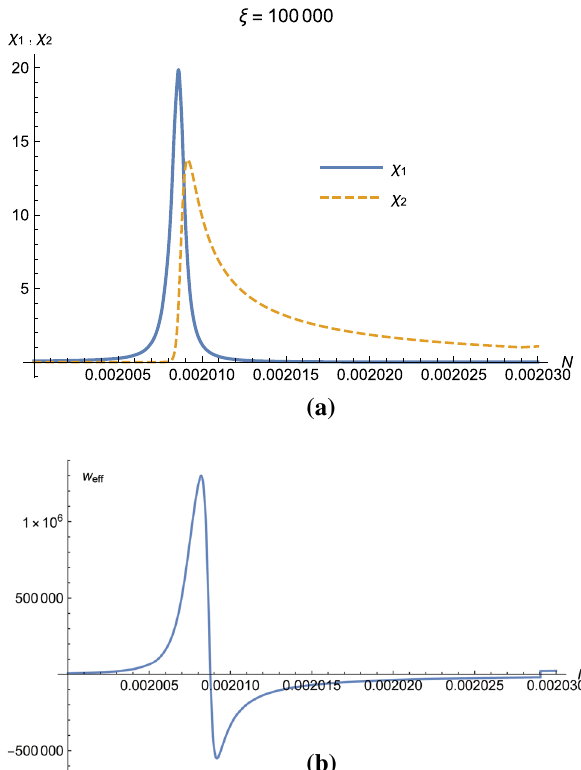
Fig. 3 Both plots above are results of the numerical calculation with ξ = 100000, χ ( 0 ) = 100 and χ ( 0 ) = 100 such that the implied steps 1 2 pushes out the field from the vicinity of the (χ 1 = 0 ,χ 2 = 1 ) point and the numerical calculationsuccessfully conducts the first oscillation. a One complete oscillation has been plotted; One has to note that the motion starts from χ 1 ( 0 ) = 100 and χ 2 ( 0 ) = 100 but the starting part has been ignored to obtain a more clear picture. b The evolution of w ef f has been plotted. As one expects for an oscillatory phase, the time average (e-folds average) of w ef f is positive and according to the numerical integration over a period it is approximately equal to 1 /